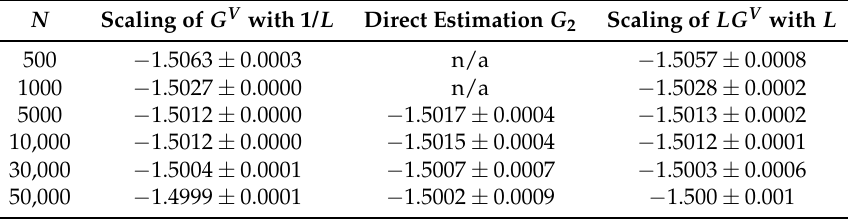
Figure 1. ( a ) RDFs for systems of different sizes of a Weeks–Chandler–Andersen (WCA) fluid at T = 2 and ρ = 0.6 (dimensionless units). Molecular dynamics (MD) simulations in the NVT ensemble were used to compute g ( r ) , and the Ganguly and van der Vegt correction [26] was applied (Equation (13)). ( b ) A zoom in of the plots in Figure ( a ) is shown. Table 3. KB integrals in the thermodynamic limit G ∞ for a WCA system at T = 2 and ρ = 0.6 (dimensionless units). Values of G ∞ are computed from systems with various number of particles N and using the different methods listed in Table